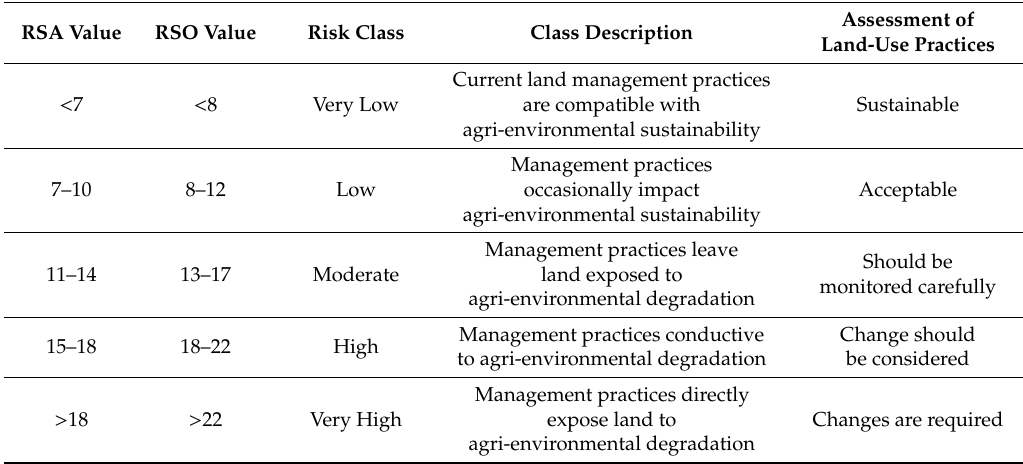
Table 7. Risk classes of soil salinization (from RSA values) and soil sodification (from RSO values), classes description, and assessment of land-use practices (adapted from Wiebe et al. [32]).